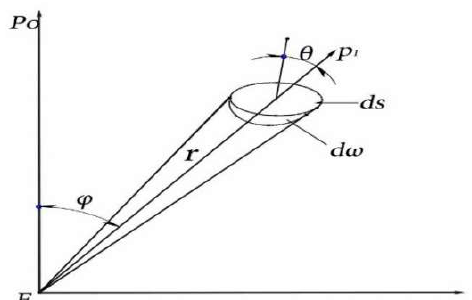
Figure 3. Influence of angle on thickness of film. Where d s is the substrate element, d ω is the solid angle, r is the evaporation distance. φ is the angle between the source normal and the line connecting the evaporation source to the substrate element, θ is the angle between the surface normal of the film and the line connecting the evaporation source to the substrate element, E is the evaporation source.